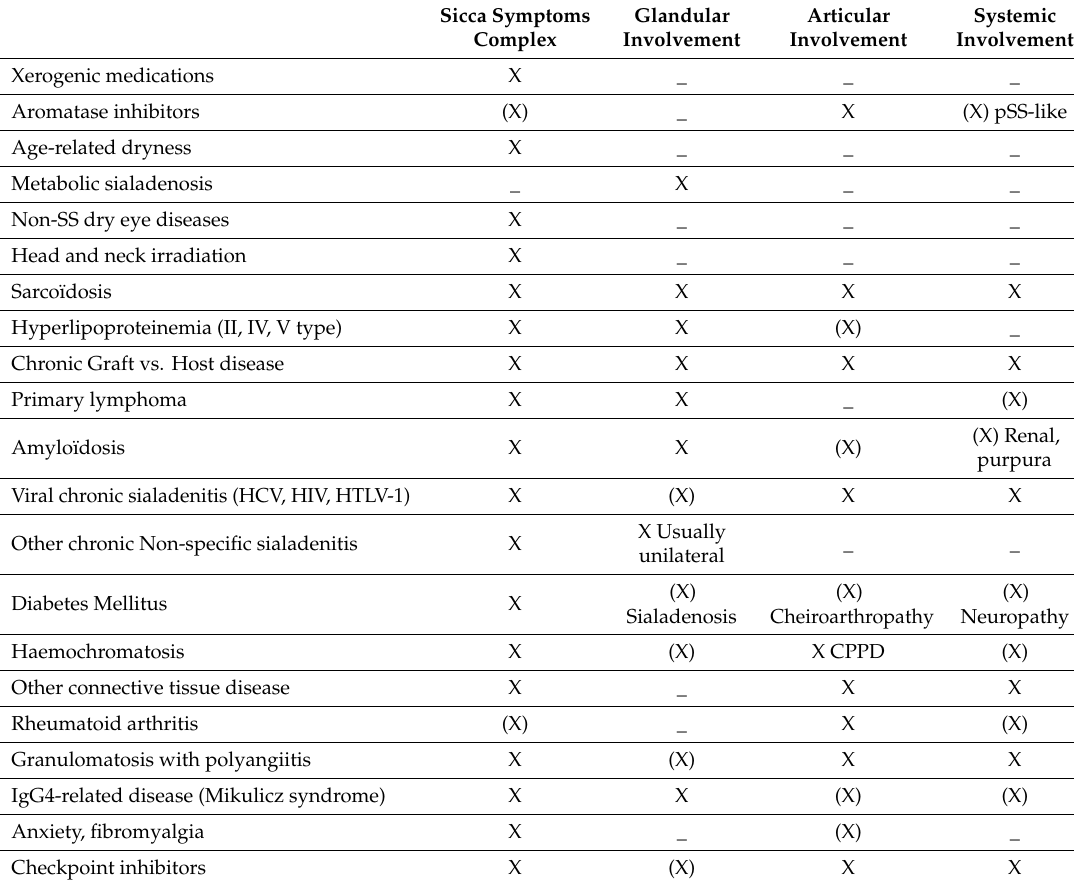
Table 3. Di ff erential diagnosis of Sjögren’s syndrome (non-exhaustive list). Sicca Symptoms